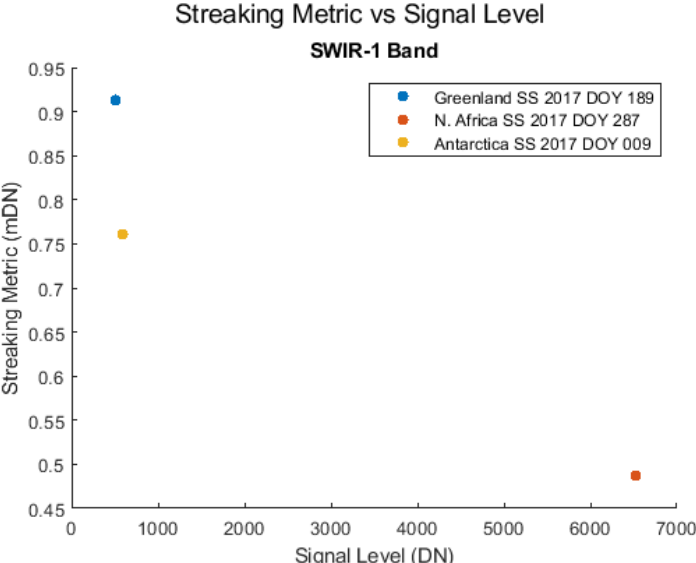
Figure 12. Signal level of region chosen for side-slither relative gain derivation vs streaking metric for three separate side slithers showing the inverse relationship between signal level and Seaking